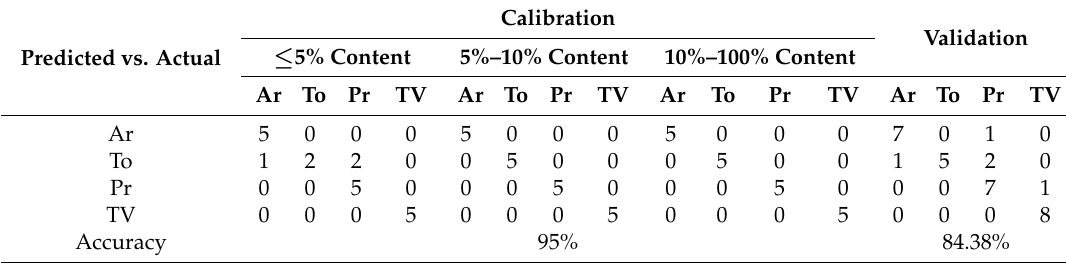
Table 3. Classified results of four soy categories using SVM with dispersive NIRS models, Ar: Arconet; To: toasted soy grits; Pr: Profam; TV: TVP; SVM: support vector machine; NIRS: near-infrared spectroscopy.